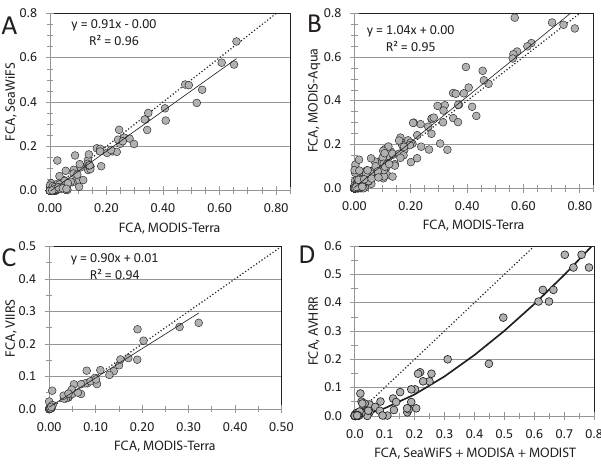
Figure 7. FCA derived with one sensor versus FCA derived with another sensor in nine areas of the Baltic. (A) SeaWiFS versus MODIST, N = 135, June–August 2000–2004. (B) MODISA ver- sus MODIST, N = 243, June–August 2002–2013. (C) VIIRS ver- sus MODIST, N = 54, June–August 2012–2013. (D) AVHRR ver- sus SeaWiFS (1998, 1999), MODISA (2005) and MODIST (2000, 2005), N = 108. The dotted line is the one-to-one line and the solid line is the estimated linear regression line. For AVHRR the power function FCA N = 0 . 85 × FCA 1 . 5 was used to convert FCA N to